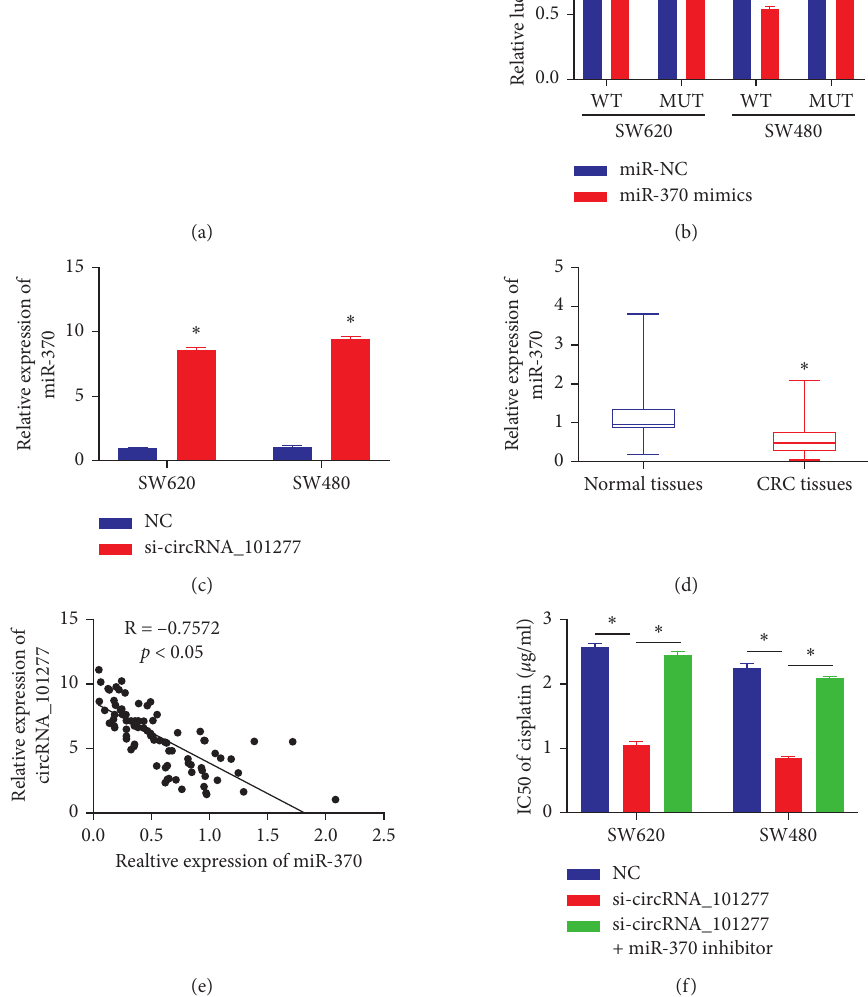
Figure 3: circRNA_101277 sequesters miR-370. (a) Putative miR-370 binding sites within circRNA_101277. (b) Relative circRNA_101277- WT luciferase activity was decreased by miR-370 mimics in CRC cells. (c) qRT-PCR was used to assess miR-370 expression. (d) CRC tissues exhibited marked miR-370 downregulation relative to normal tissues. (e) miR-370 expression was negatively correlated with that of circRNA_101277 in CRC tissues. (f) An MTT assay was used to assess the cisplatin IC50 value in the indicated cells. ∗ p <